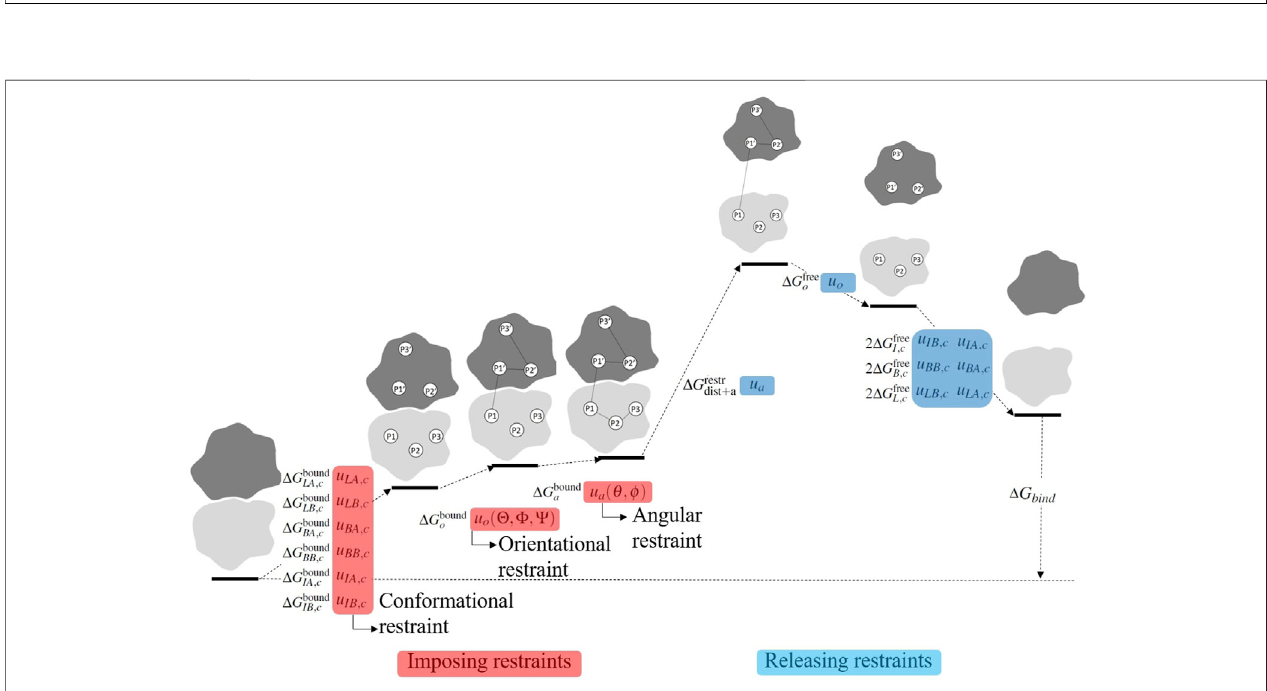
FIGURE2| Visualizationofthestepwiseprocedureofcalculatingthebindingfreeenergy Δ G bind .Inordertoaccelerateconvergence,restraintsareseriallyappliedin the bound state and serially released in the free state. The full thermodynamic process is given in Eq. 11 .